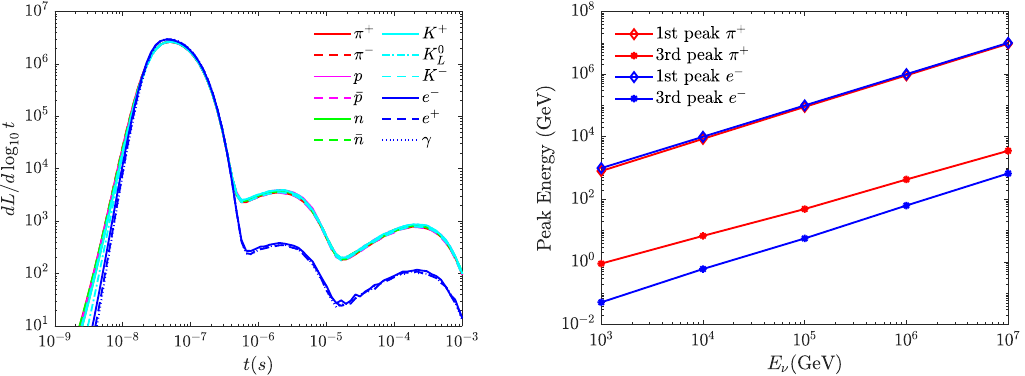
Figure 8 . Left: spectrum of Cherenkov light produced as a function of time by propagating a 1 PeV particle in ice using FLUKA. The y-axis is in arbitrary units. Relatively long-lived particles are simulated including (cid:25) + (solid red), (cid:25) (cid:0) (dashed red), proton (solid magenta), antiproton(dashed magenta), neutron (solid green), antineutron (dashed green), K + (solid cyan), K (cid:0) (dashed cyan), K 0 (long-lived eigenstate, dash-dotted cyan), electron (solid blue), positron (dashed blue) and L photon (dotted blue) | these last three overlap on the lower curve, whereas the others overlap on the upper one. Right: energy of the (cid:12)rst peak (line with diamonds) and third peak (line with asterisks) in the Cherenkov light spectrum as a function of particle energy. (cid:25) + is shown in red and electron is shown in blue. The peak energies are normalized so that the energy of the (cid:12)rst peak at 10 PeV equals the energy of the injected